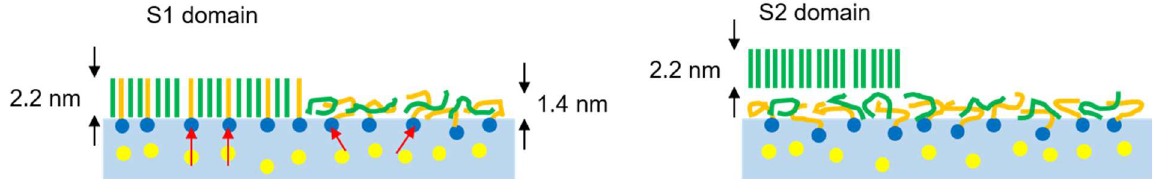
Figure 5. Schematic illustrations for the S1 domain of the C16TAB-C16 system ( left ) and for the S2 domain of the C14TAB-C16 system ( right ). Red arrows in the aqueous phase are dipoles on the hydrophilic groups. Surfactant hydrophobic chains and alkane molecules are, respectively, colored by orange and green to illustrate the difference visibly.